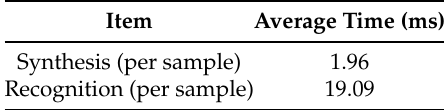
Table 7. Computational efficiency of our proposed